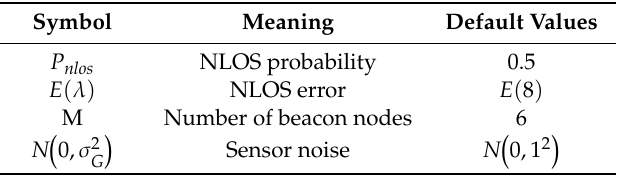
Table 6. The default parameters for exponential distribution.